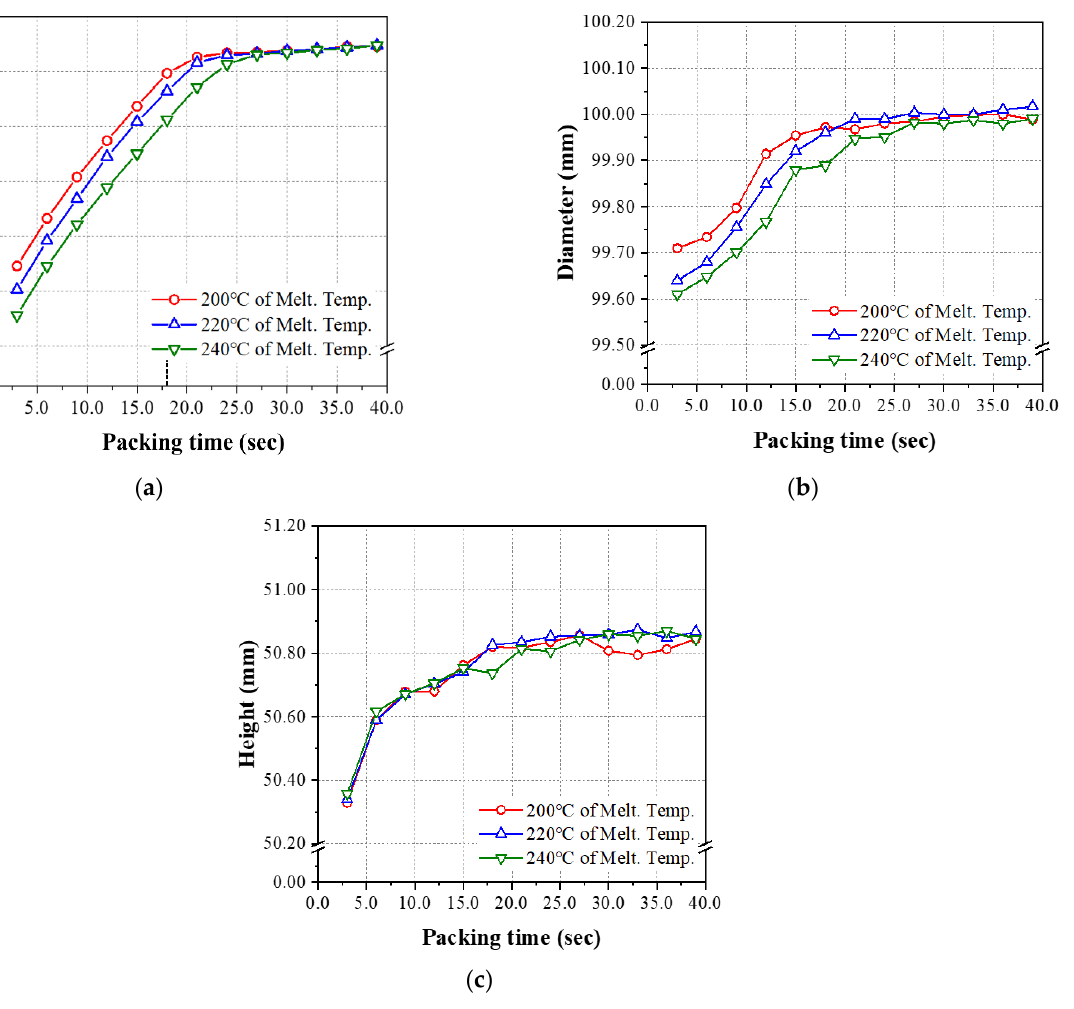
Figure 6. Experimental measurement results for the process conditions of Table 5 showing nonline- arity (packing time: 3.0~39.0 s): ( a ) mass, ( b ) diameter, and ( c ) height. ity (packing time: 3.0~39.0 s): ( a ) mass, ( b ) diameter, and ( c )